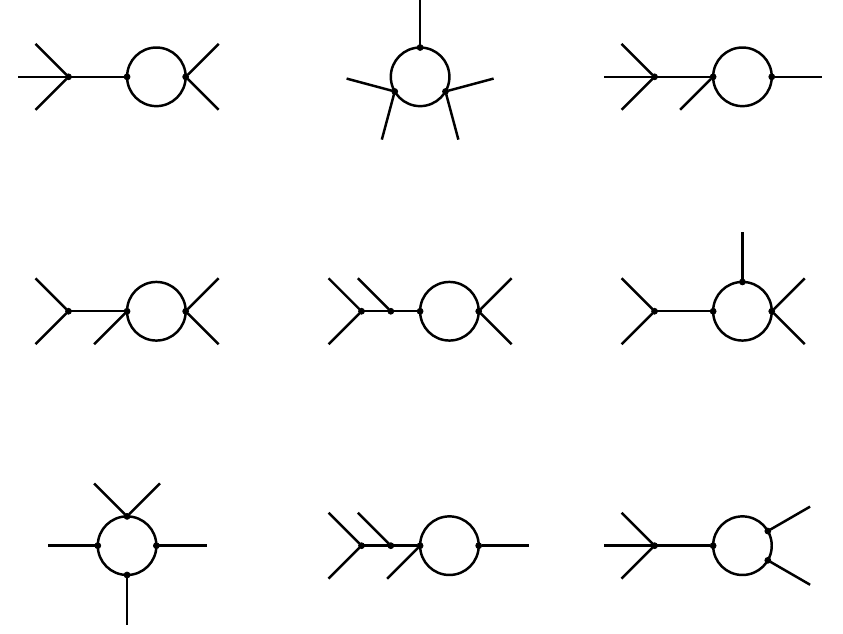
Figure 3 . The one-loop topologies that always lead to non-renormalizable